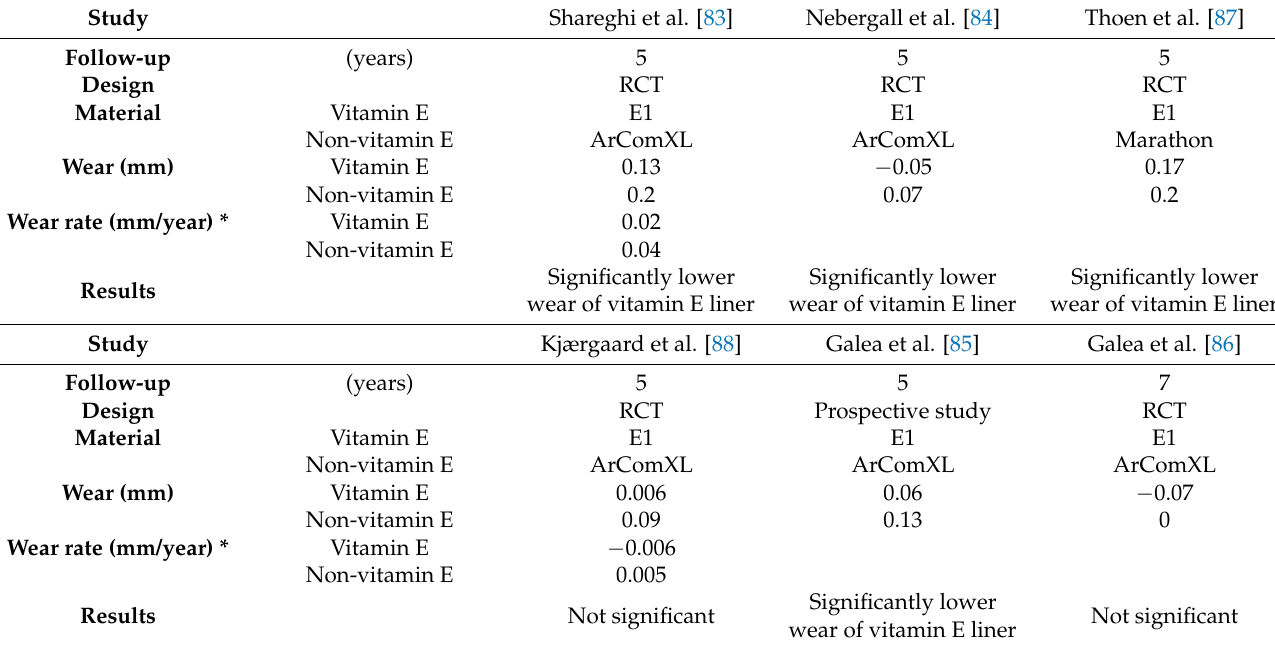
Table 4. Comparison of polyethylene wear with vitamin E liner and non-vitamin E